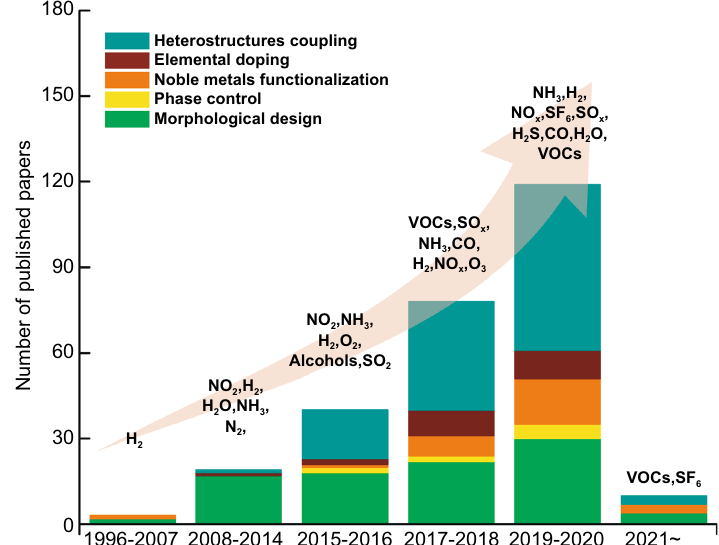
Fig. 10 Number of publications reporting advanced strategies to enhance gas sensing properties of MoS 2 toward various gas detection. Data are obtained from Web of Science (WoS) as of April 2, 2021, with the keyword “MoS 2 gas sensing.” Both experimental and computational reported are included. Review and perspective articles are excluded